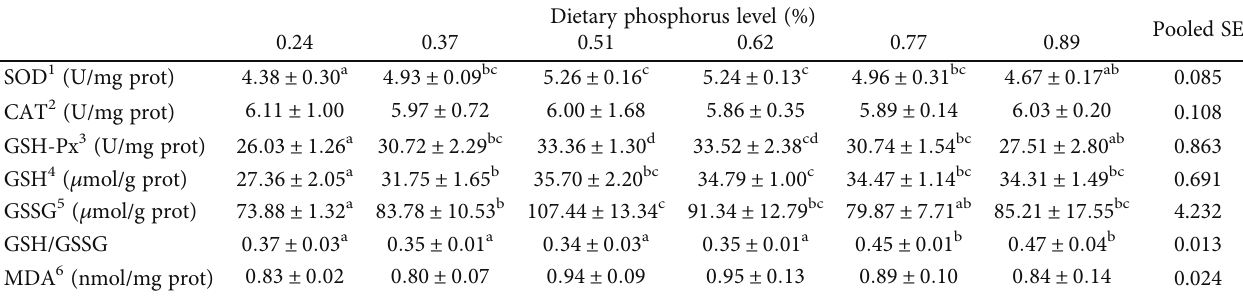
Table 6: The intestinal oxidation resistance of sea cucumber fed diets with di ff erent phosphorus levels. Dietary phosphorus level